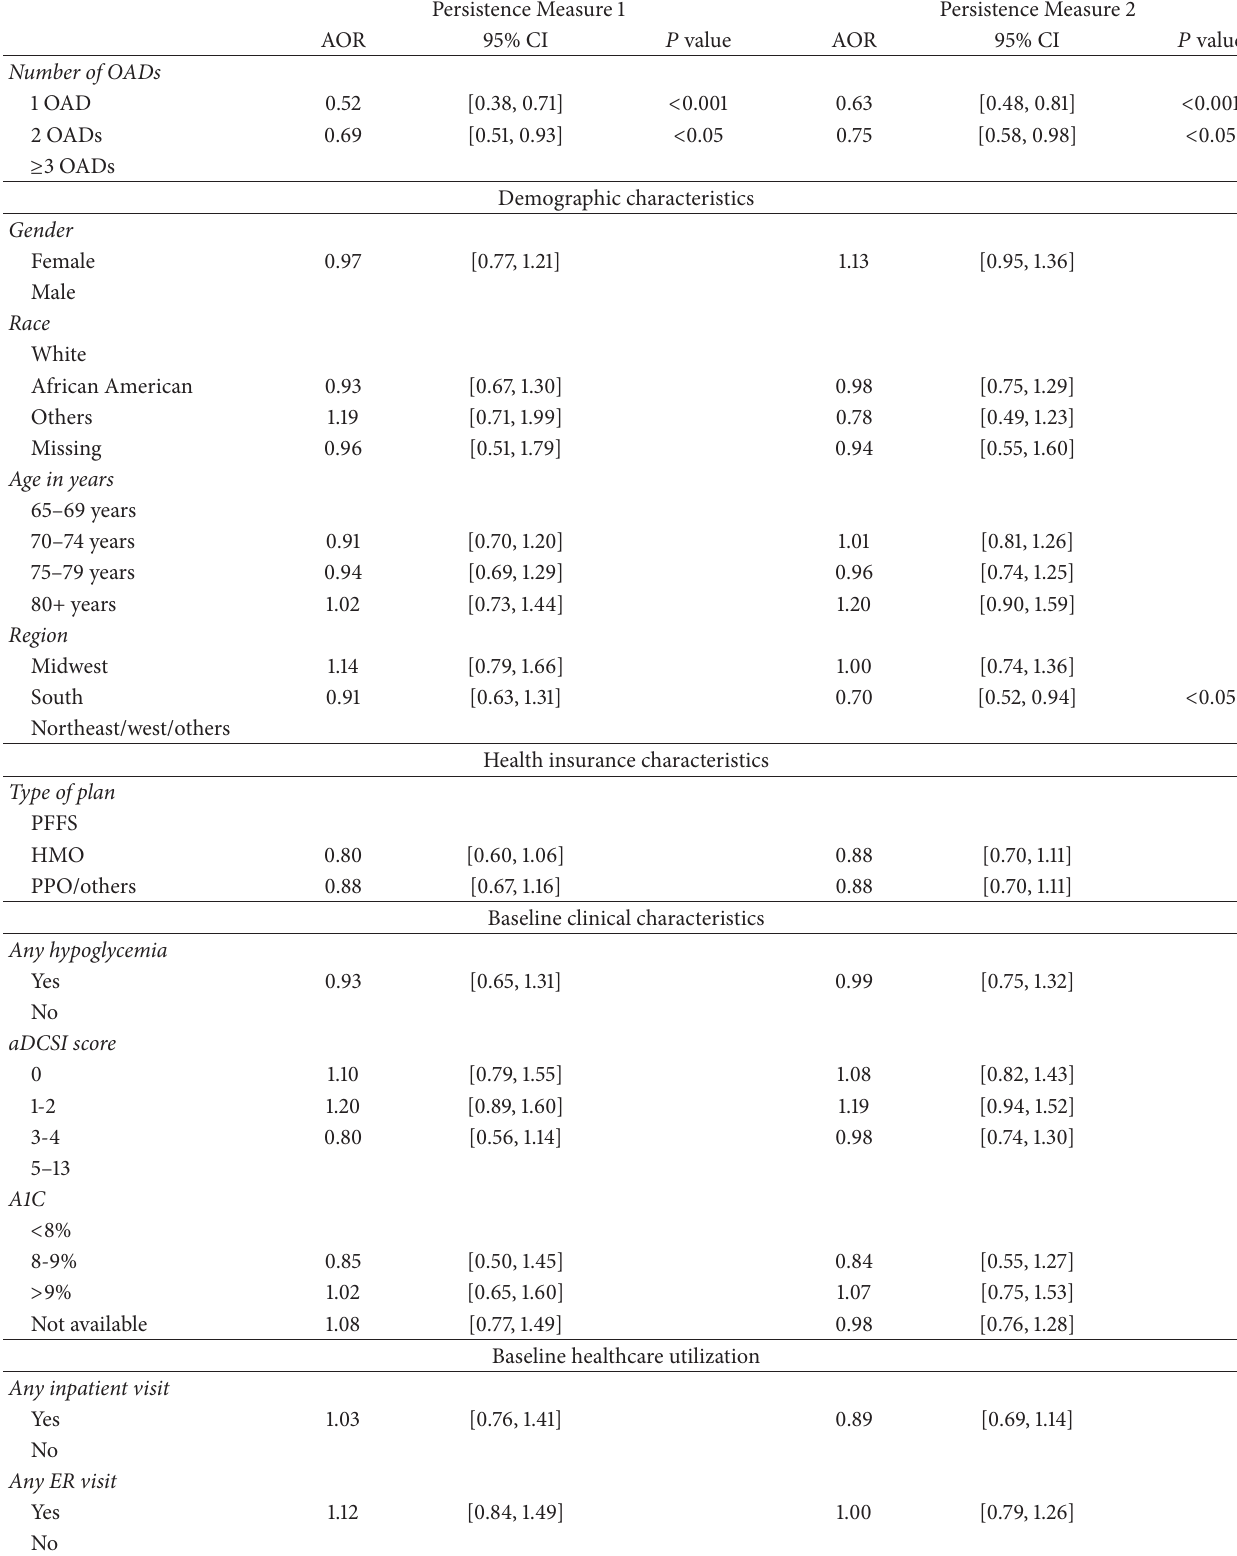
Table 5: Adjusted odds ratios and 95% confidence intervals from logistic regressions of rapid acting insulin persistence during